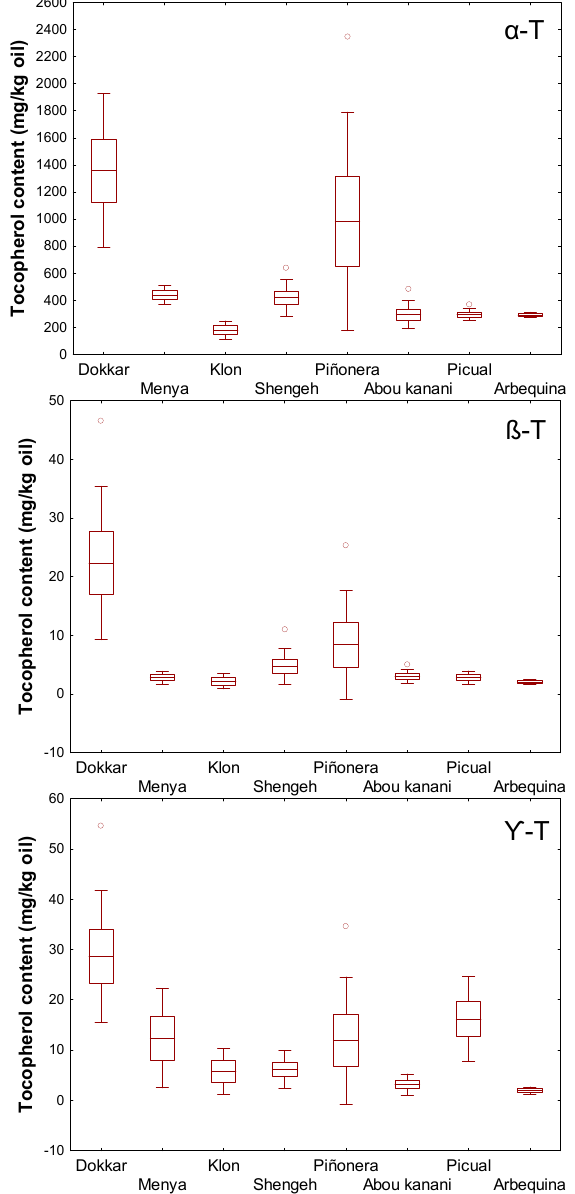
Figure 4. Variability across years for the contents (mg / kg oil) of the three forms of tocopherol in the oils from selected cultivars from WOGC: α -T, α -tocopherol; β -T, β -tocopherol; γ -T, γ -tocopherol. Horizontal inner lines in the boxes are mean values. The height in a box is equal to the standard error and the whiskers to standard deviation. The outliers (open dots) are indicated outside the whiskers.